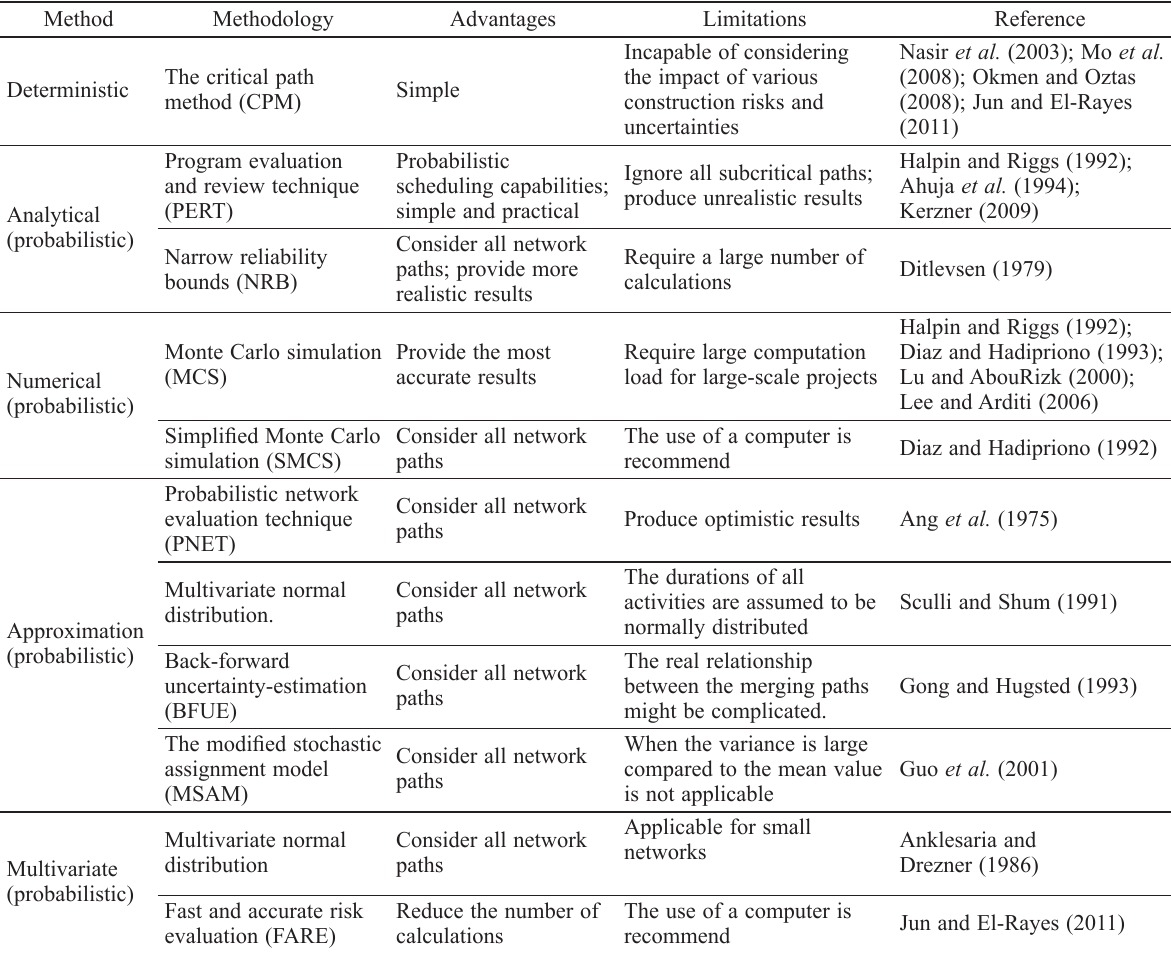
Table 1. Methods for the reliability of project completion time in